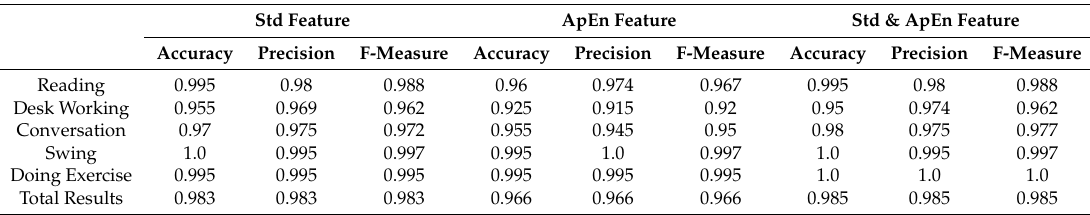
Table 9. Activity recognition for using the novel designed cushion.